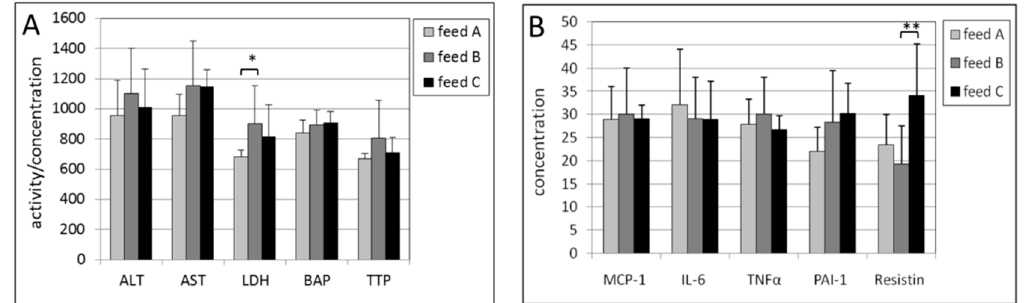
Figure 6. ( A ) Activities of ALT, AST and, LDH, and concentrations of BAP and TTP in the post-mitochondrial supernatant of kidney tissue of female mice. The levels of ALT, LDH, BAP and TTL were multiplied by a factor of 10, 0.1, 5 and 20, respectively, to fit in the figure; ( B ) Concentrations of MCP-1, IL-6, TNF- α , PAI-1 and resistin in the post-mitochondrial supernatant of kidney tissue of female mice. The levels of MCP-1, IL-6, TNF- α and resistin were multiplied by a factor of 5, 10, 20 and 5, respectively, to fit in the figure. The levels of feed B were tested statistically relative to those of feed A, and the levels of feed C relative to those of feed B. * p < 0.05; ** p < 0.01.